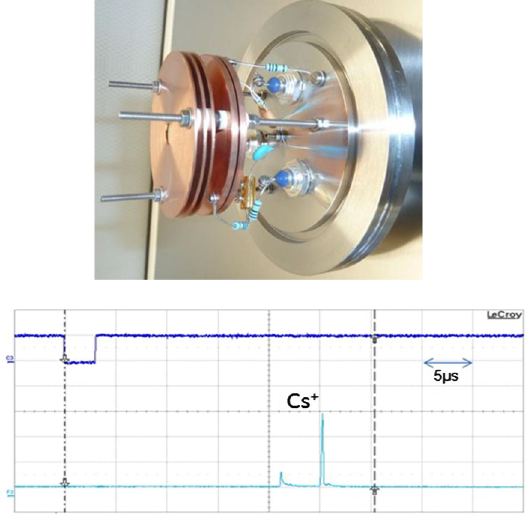
FIG. 9. An overview of the MCP detector (top) and cooled ions TOF spectrum for 1 μ A of beam current under the optimum cooling conditions (bottom).